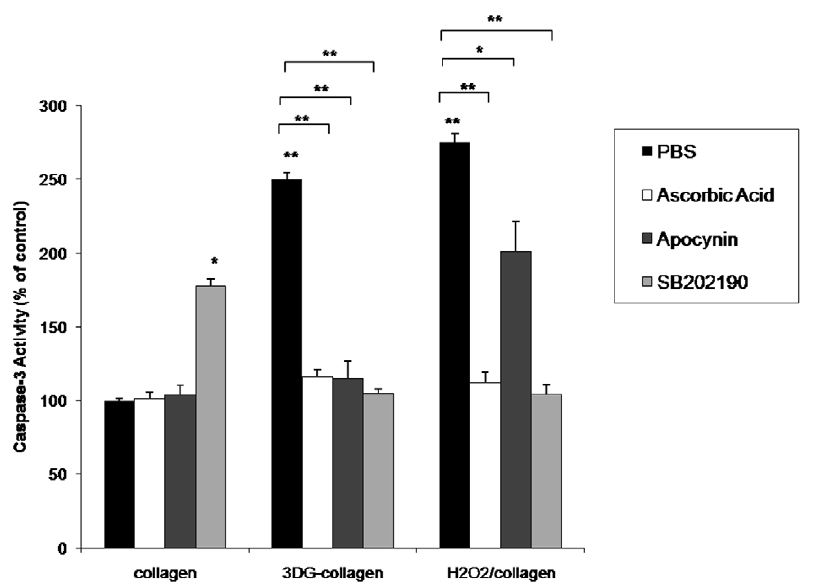
Figure 7. Inhibition of ROS, and p38 MAPK reduces caspase-3 cleavage induced by 3DG-collagen. Fibroblasts were pretreated with 100 m g/mL of ascorbic acid, 1 mM apocynin, or 10 m M SB202190 for 1 h and cultured on native collagen, 1 mM 3 DG-collagen, or treated with 50 m M H 2 O 2 for 24 h. Treatment of fibroblasts with 50 m M H 2 O 2 for 24 h was used as a positive control. 100 m g of whole cell lysate was assayed for caspase-3 activity according to the protocol from Caspase-3 Colorimetric Correlate Assay. All samples were performed in triplicate and normalized to the control samples. All comparisons are made against collagen treated with PBS unless otherwise indicated. Data are mean 6 SD (n=3), **P , 0.0002, *P , 0.001.